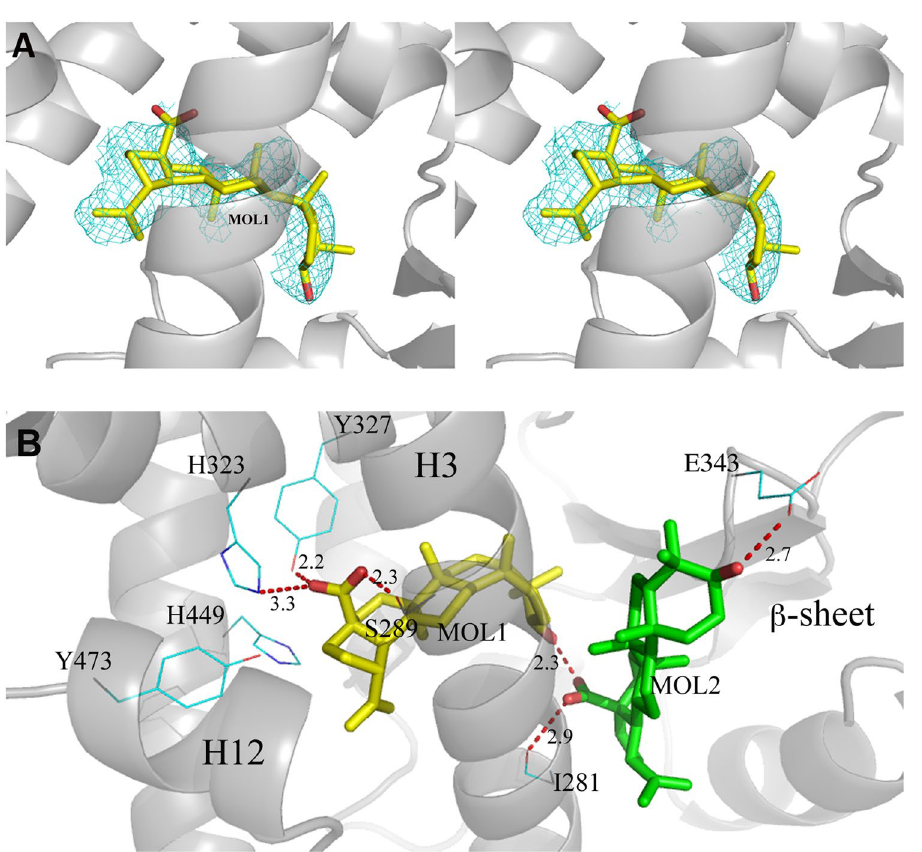
Figure 3. BA interactions with the LBD of PPAR γ . ( A ) 2Fo-Fc omit map around molecule 1 of BA (yellow) is shown in mesh and contoured at 0.7 σ ; ( B ) H-bond interactions (red dashed lines) of molecule 1 (yellow) and the docked molecule 2 (green) of BA with residues of the LBD of PPAR γ